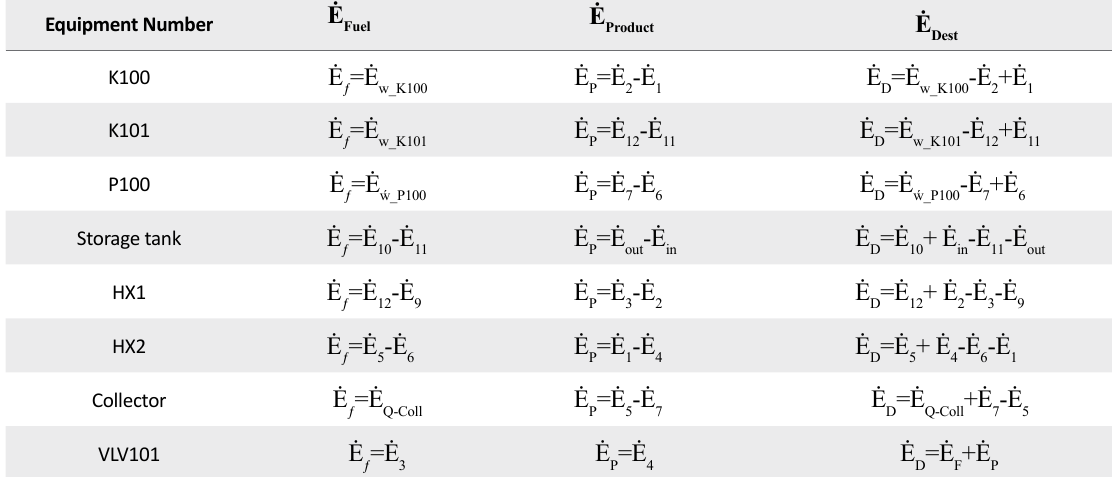
Table 6. Results of exergy in fuel, product and destruction of hot water production system with weather conditions of